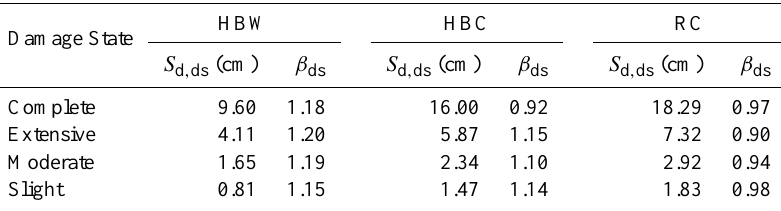
Table 3. The median displacement threshold to reach a certain damage state ( S d , ds ) for modelled building types and their corresponding log-normal standard deviation ( β ds ) .